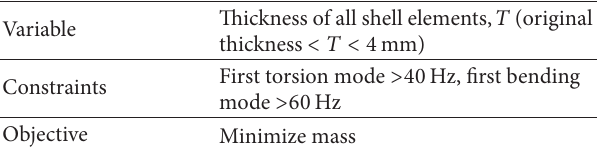
Table 1: Topology optimization criteria settings. Table 2: Result comparison of original and optimized model.